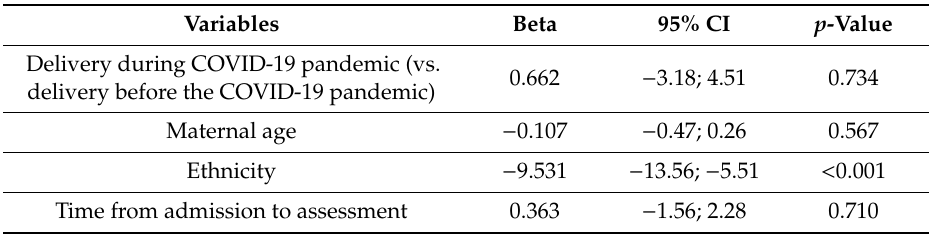
Table 5. Multivariable regression model for the association between delivery during COVID-19 pandemic and maternal objective cognitive test (SDMT90).